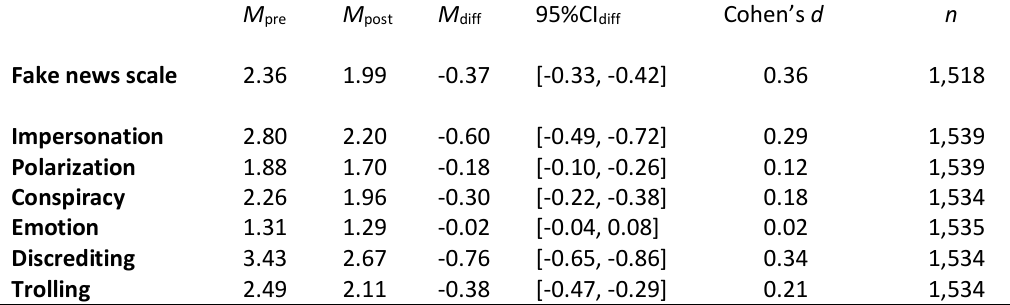
Table 5. Average reliability (pre-post) judgments overall and for each fake news badge by country